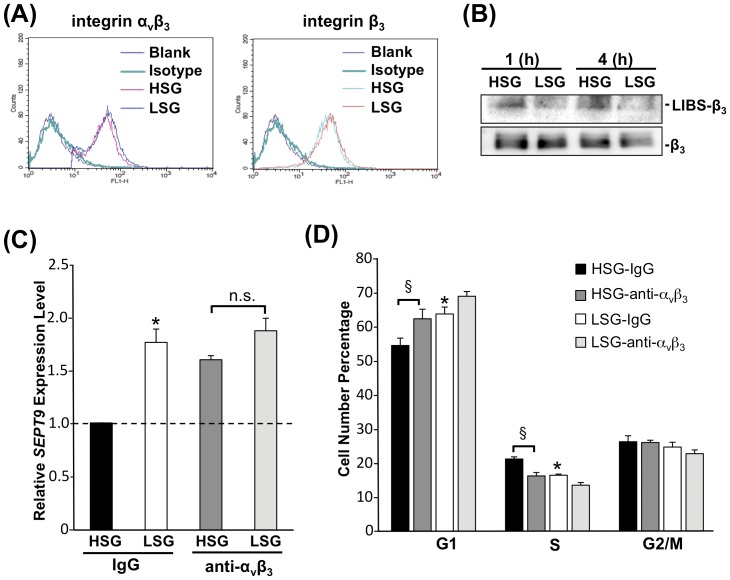
Integrin αvβ3 mediates the stiffness-modulation of SEPT9 expression and EC proliferation.(A) Integrin expression profiles of ECs on HSG and LSG. ECs on HSG and LSG for 24 h were stained with integrin antibodies against integrin αvβ3 and integrin β3 and analyzed by flow cytometry. The green-line histogram represents the isotype control. The red- and blue-line histograms represent the surface expressions of the specific integrins on HSG and LSG, respectively. (B) ECs were seeded on HSG and LSG for the indicated times and cell lysates were immunoblotted with antibodies against the LIBS-β3 domain (ligand-induced binding site), and β3 (total integrin β3). (C–D) ECs were pretreated with integrin αvβ3 blocking antibody (10 µg/mL) or IgG for 2 h prior to be seeded on HSG and LSG for 24 h followed by qPCR assays for SEPT9 expression (C) and cell cycle analyses by flow cytometry (D). * p<0.05 in comparison with the corresponding IgG controls on HSG and LSG. § p<0.05 for comparison between IgG control and integrin αvβ3 blocking antibody treatment on HSG. n.s. indicates no significant difference. (n = 5 for SEPT9 expression and n = 3 for cell cycle analyses).